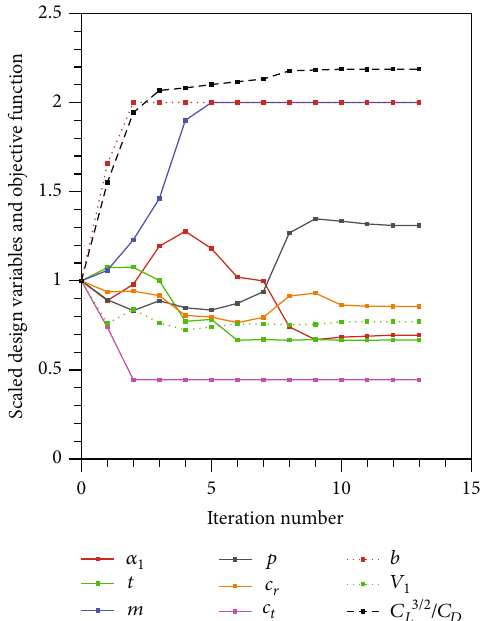
Figure 15: The variation of the objective function and the design variables in Case 1.